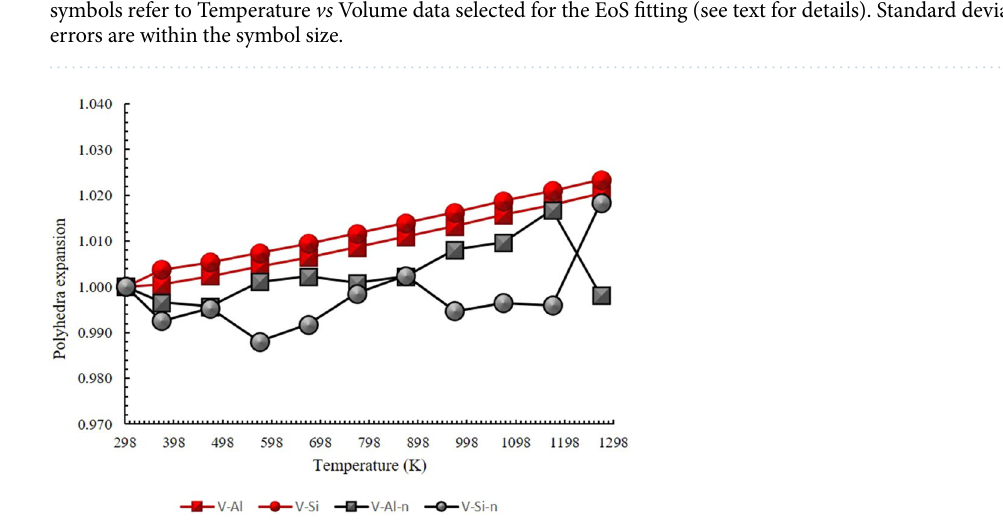
Figure 7. Polyhedral evolution of topaz expressed as V / V 0, with V–Al and V–Si indicating octahedral and tetrahedral volume respectively, as obtained from synchrotron (red symbols) and neutron (grey symbols) data. For in situ neutron data the octahedral expansion is regularly counterbalanced by a tetrahedral contraction, up to 1170 K. Above this temperature, the fluorine loss induced a structural modification that suddenly change this trend. More details are reported in Fig. 8. Standard deviation errors are within the symbol